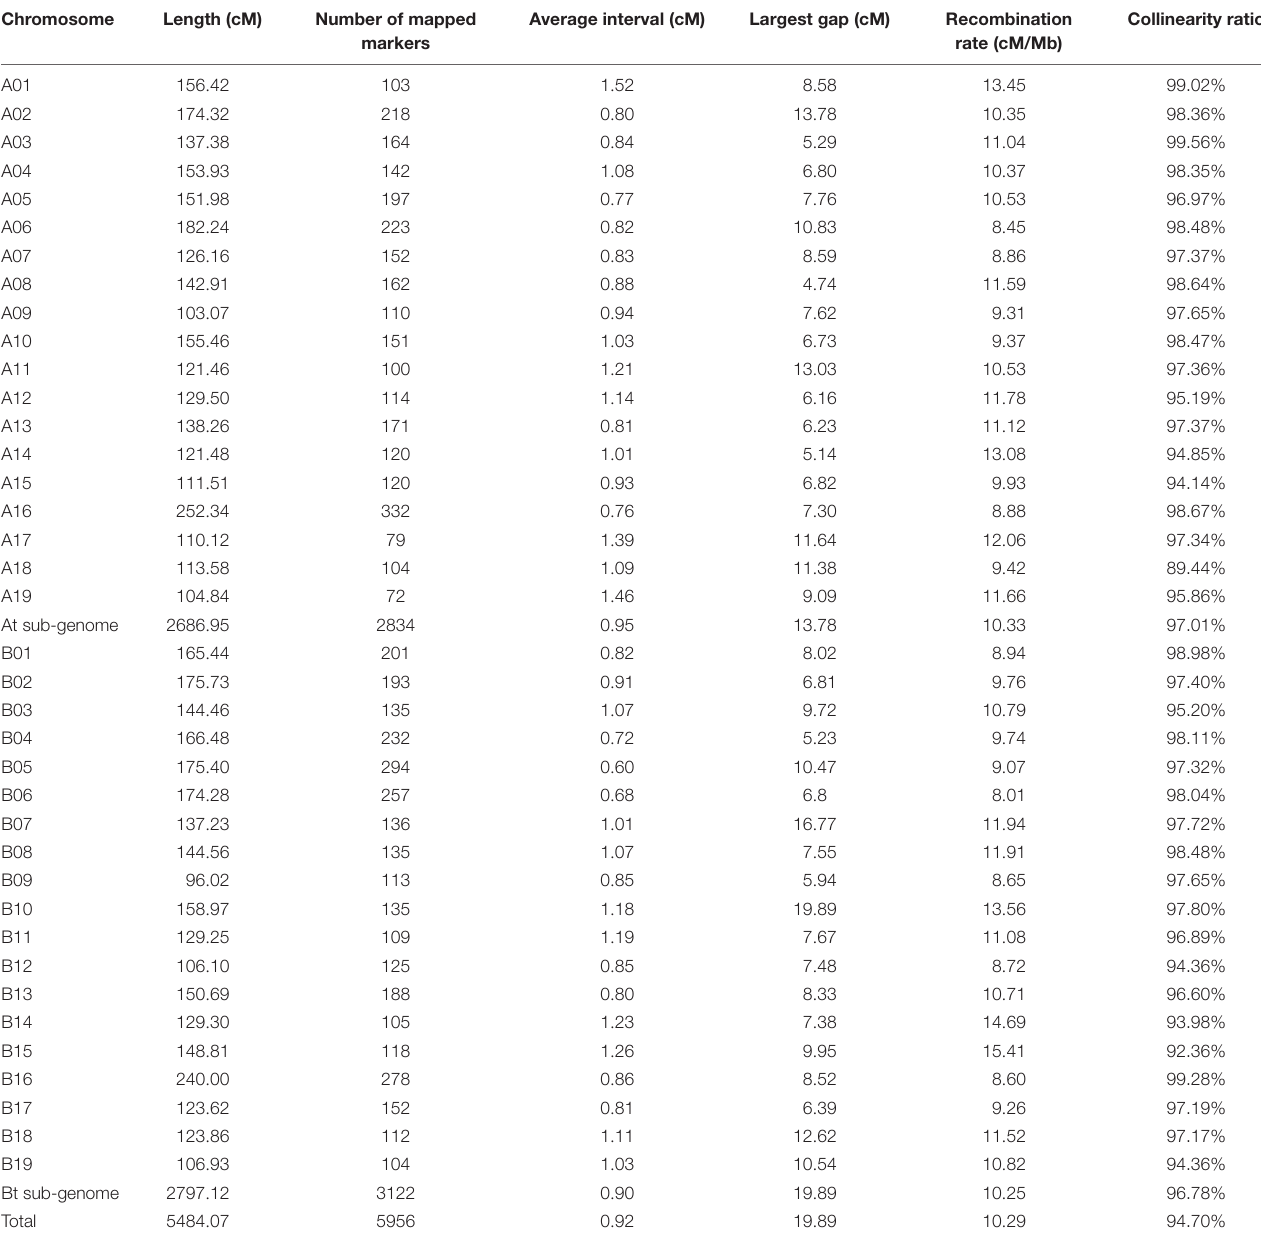
TABLE 2 | Detailed information on the high-density genetic map. Chromosome Length (cM) Number of mapped